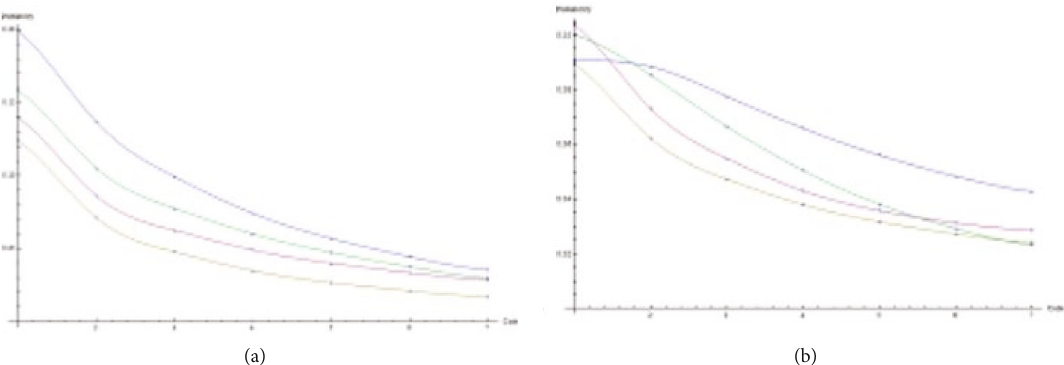
Figure 6: Result of maximum likelihood. (a) Mixture distribution for four di ff erent images. (b) After few iterations of maximum likelihood.